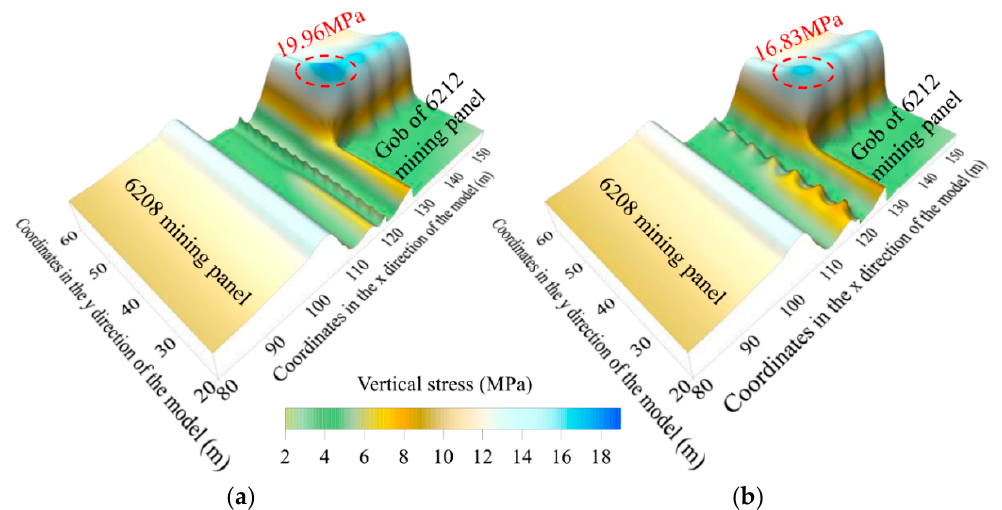
Figure 17. The roof stress distribution characteristics under 6212 mining panel retreating: ( a ) penetrating fracture; ( b ) length of the non-penetrating fracture: 5 m.